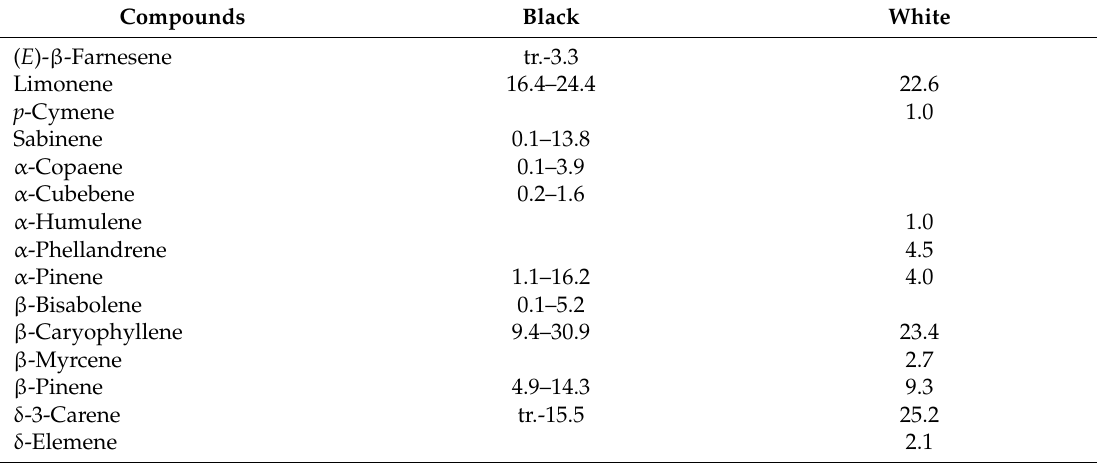
Table 10. Major components (%) of Piper nigrum L. fruit essential oils [64,65]. Compounds